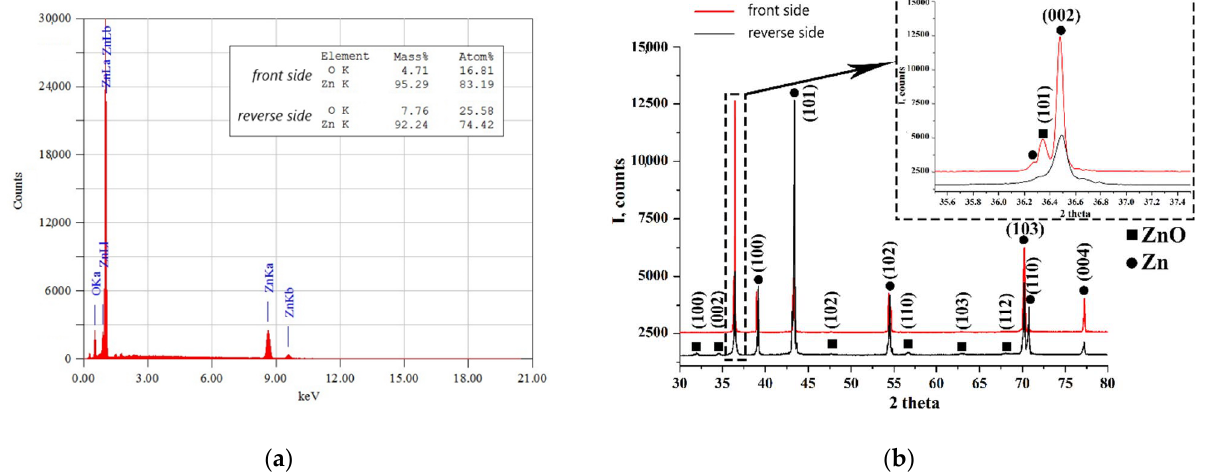
Figure 5. Structural and element comparison of the front and reverse sides of the N1 film: ( a ) a typical EDX spectrum of the film (the front surface); the inset shows the composition of elements at particular areas of both surfaces of the film. ( b ) XRD patterns for the front (top, red line) and reverse (bottom, black line) sides of the film; squares and circles indicate ZnO and Zn reflections, respectively.